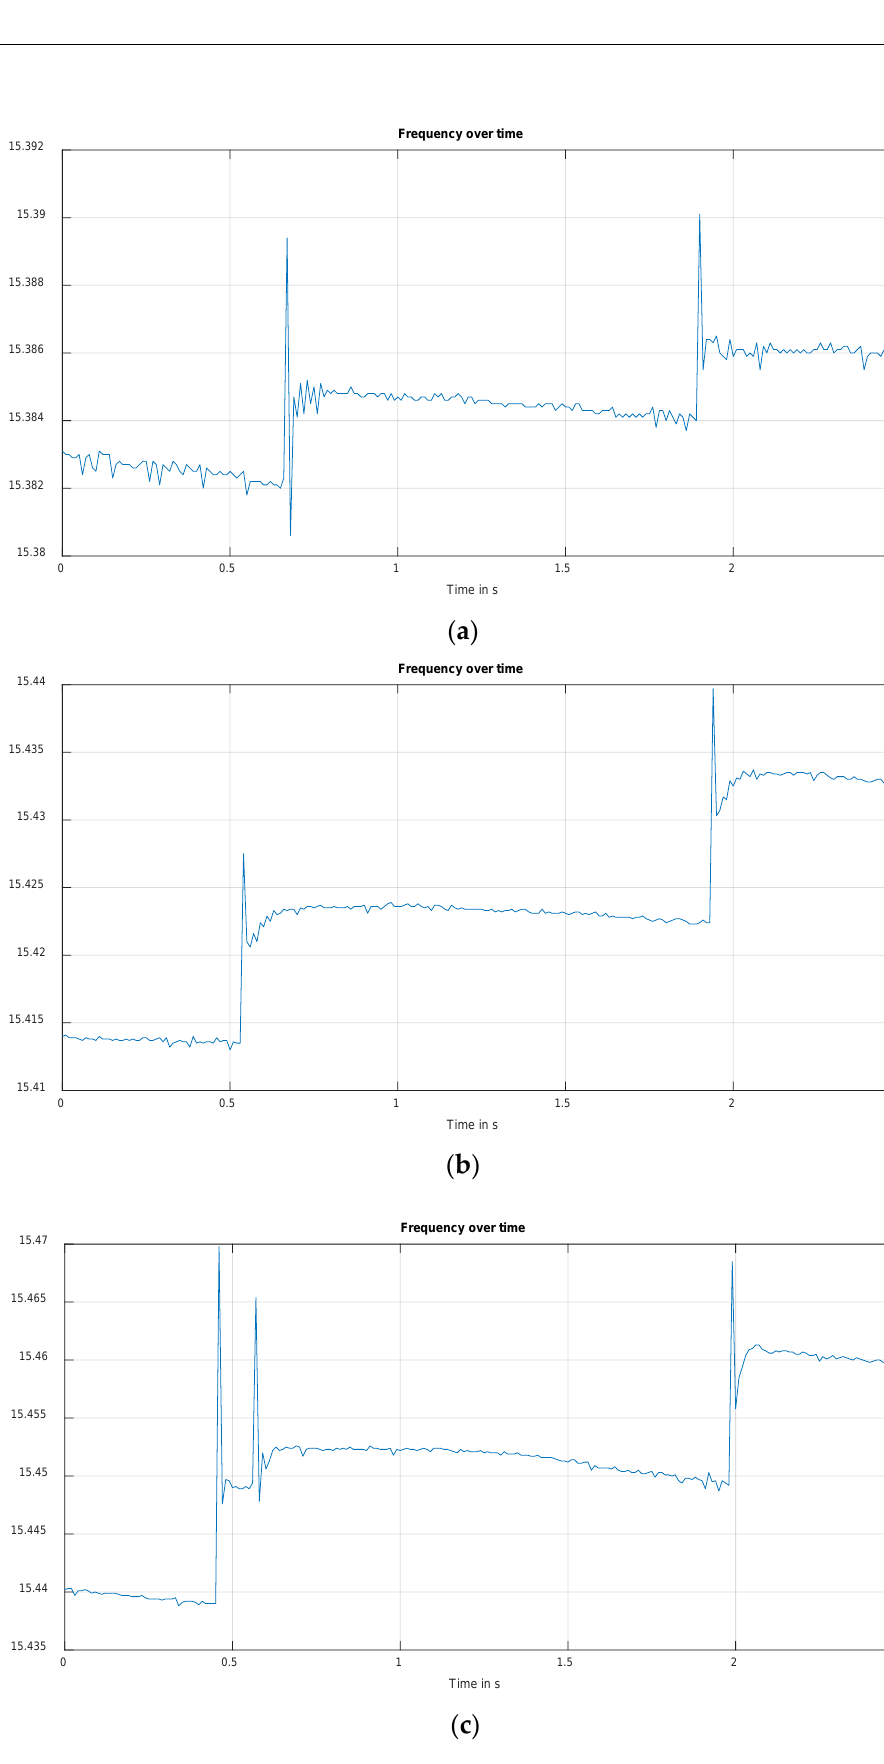
Figure 9. Frequency over time of measurements 1–3.